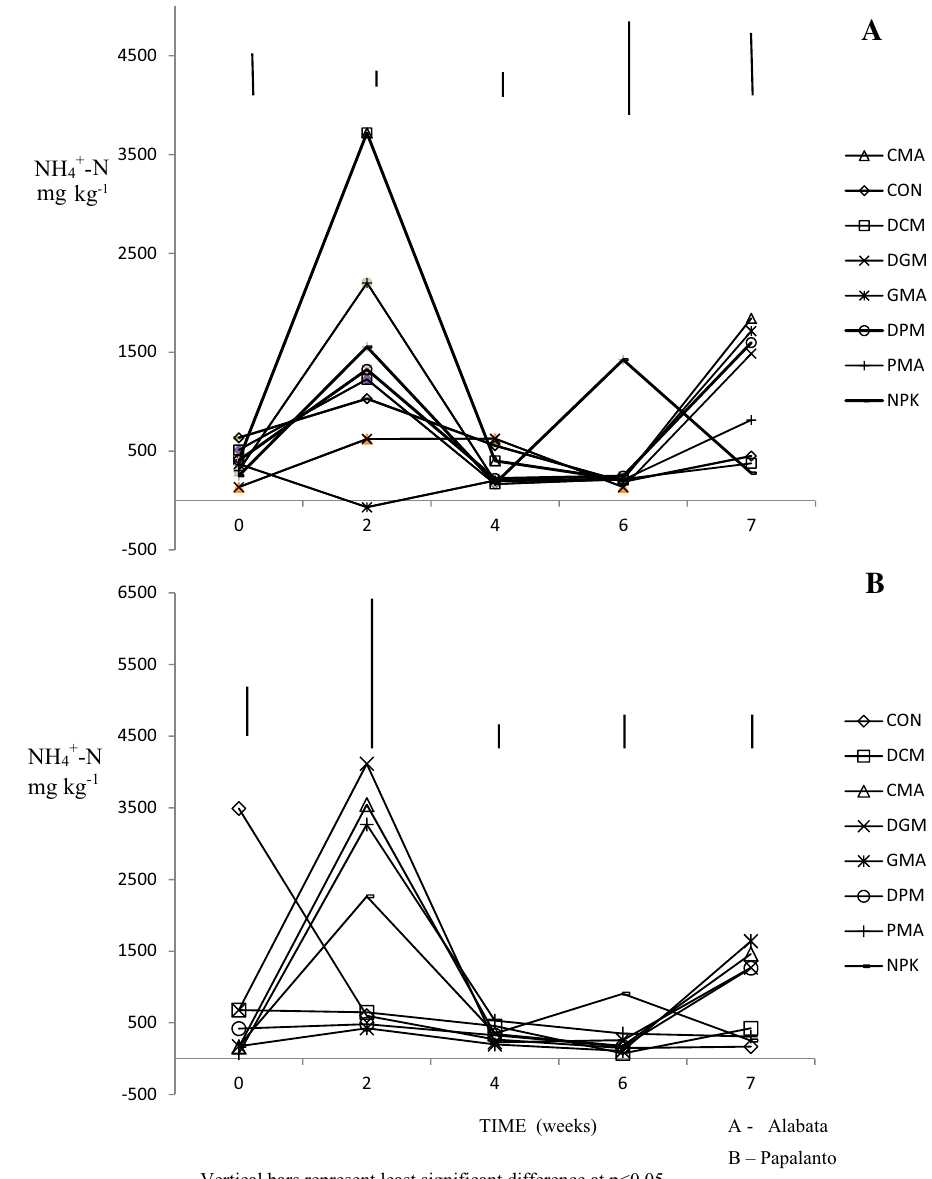
Fig. 4 Changes in soil ammo-